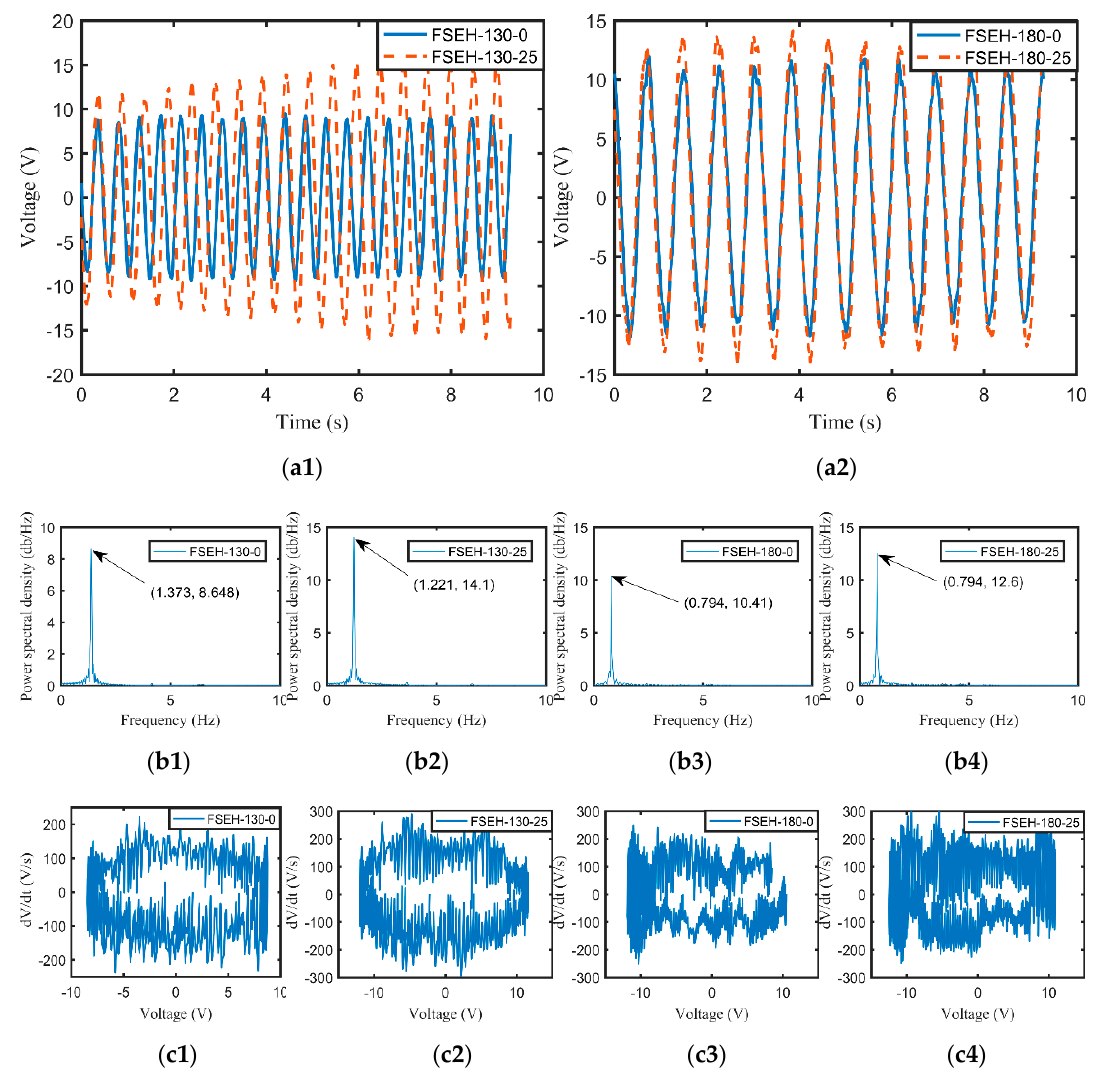
Figure 4. Time history, power spectral density, and phase portrait of output voltage for FSEH-130-0, FSEH-130-25, FSEH-180-0, and FSEH-180-25 at 10.52 m/s: ( a ) time history; ( b ) power spectral density; and ( c ) phase portrait.